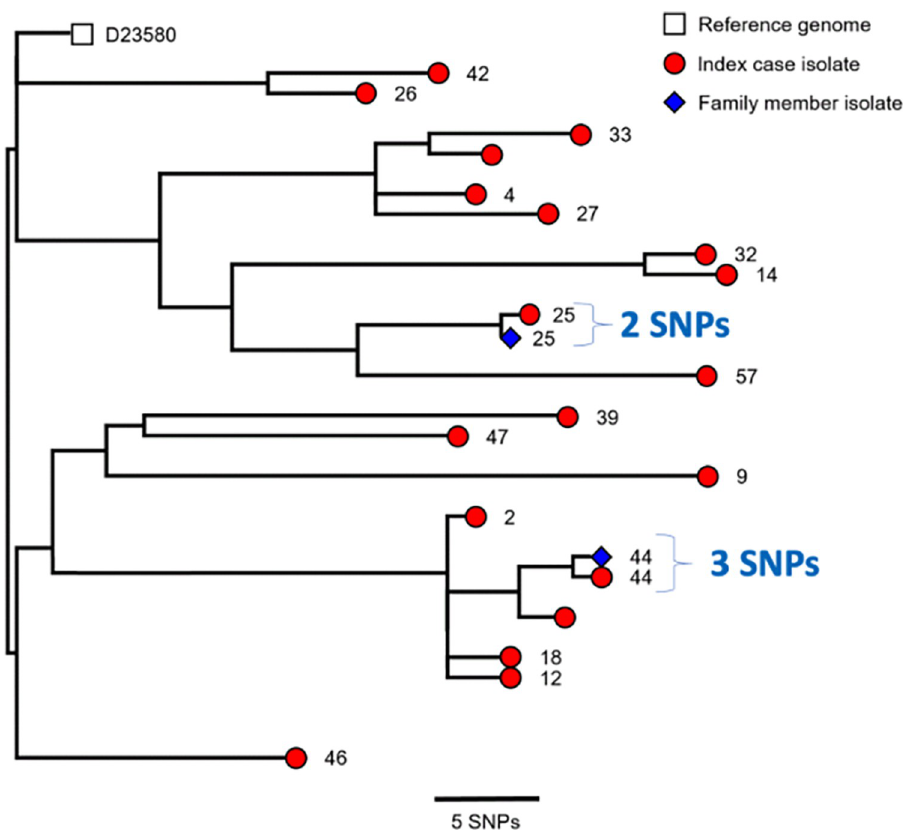
Fig 3. The close relationship between the index case and family member isolates from households 25 and 44 shown with a phylogenetic tree. Whole genome maximum likelihood tree of 19 S. Typhimurium isolates described in Table 2. The numbers at the end of each branch indicate household, as described in the first column of Table 2 (all these households are case households). Sequencing read sets were compared against the reference genome D23580 as described in